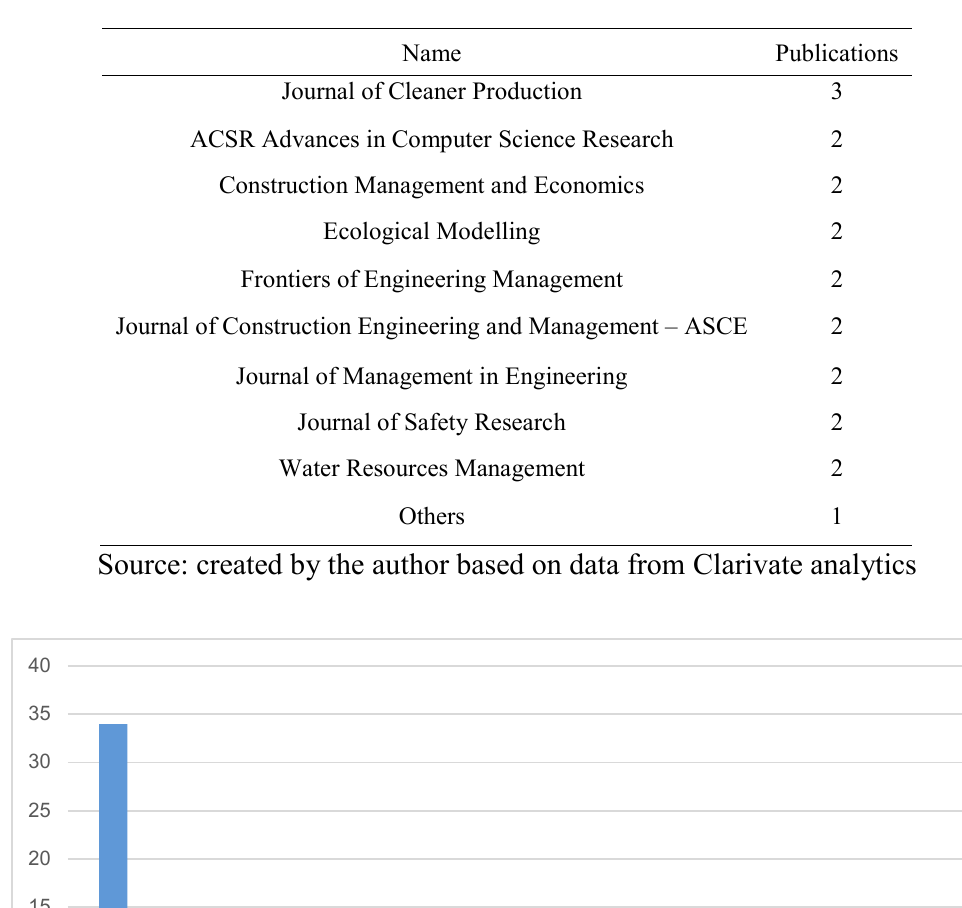
Table 1. Journals Publishing the Most Articles Related to System Dynamics